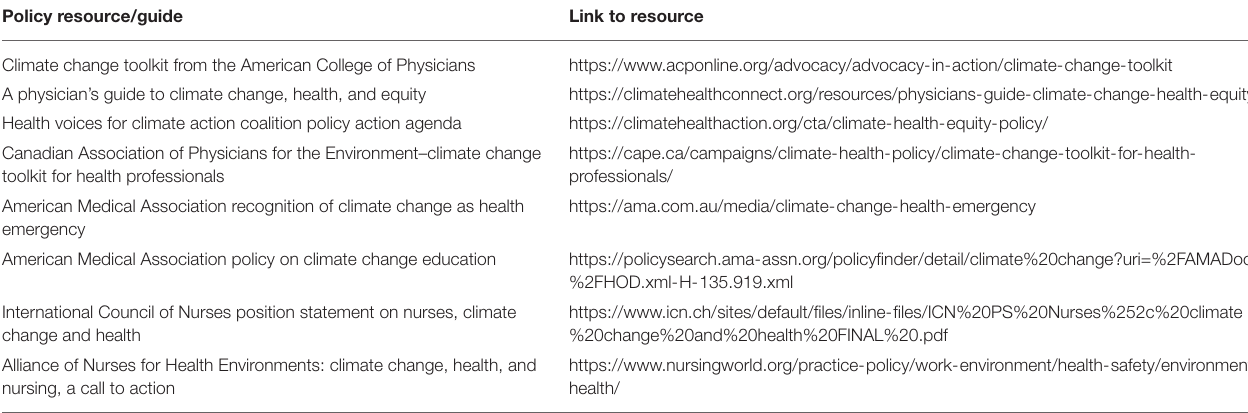
TABLE 1 | Select climate change policy calls to action, resources, and practitioner guides. Policy